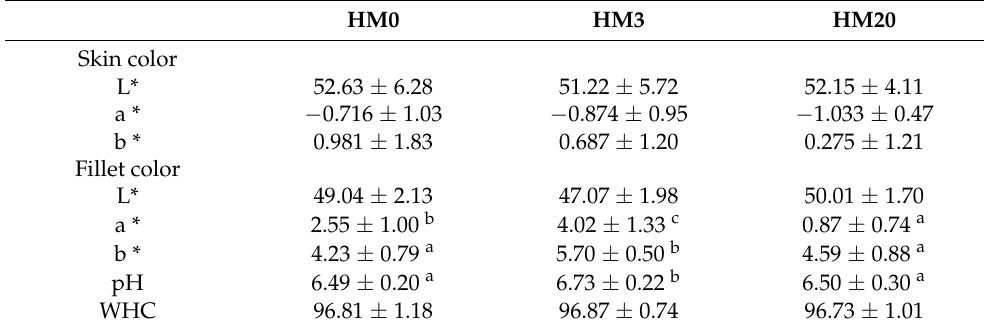
Table 6. Physical traits of the fillets from rainbow trout fed the three experimental diets. HM0 HM3